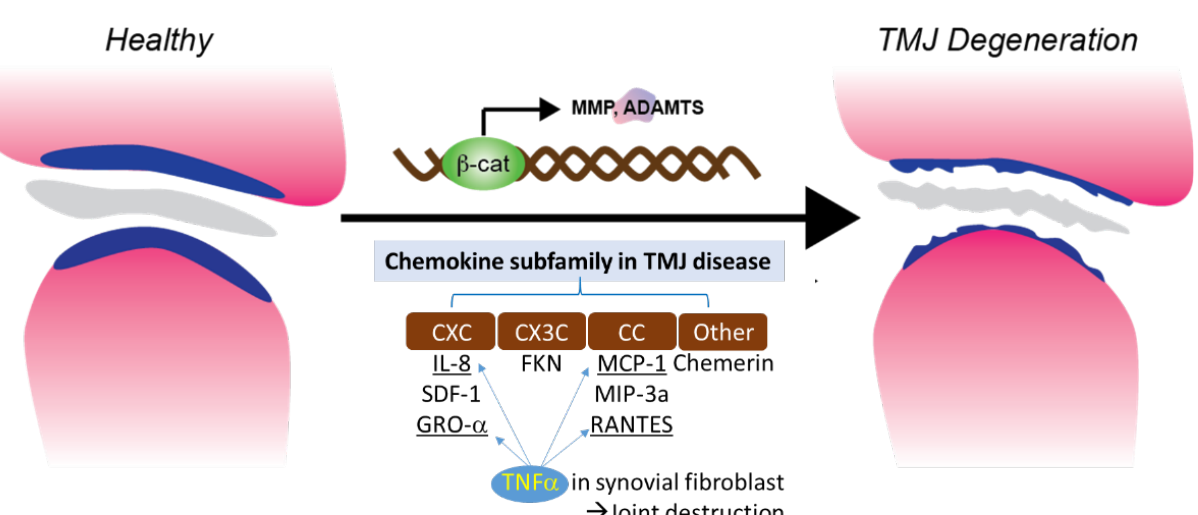
Figure 1. Chemokine subfamily associated with  -catenin and TNF  signaling in synovial